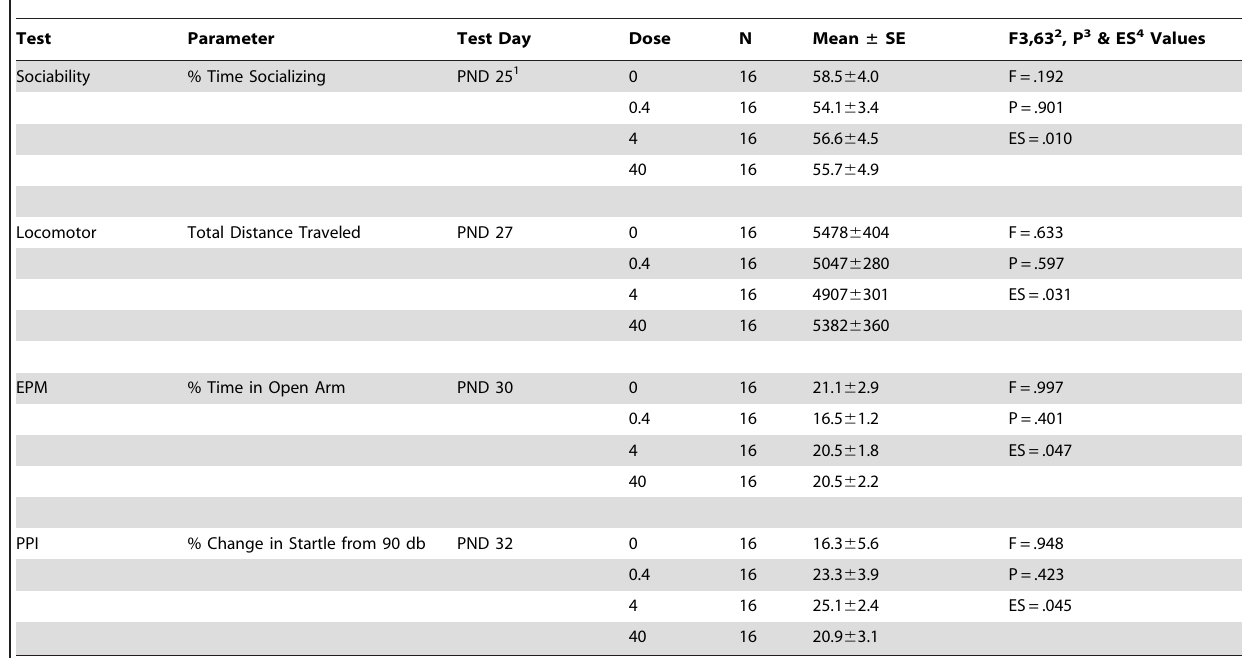
Table 1. Summary of main effects for statistical analyses of behavioral performance across treatment groups.